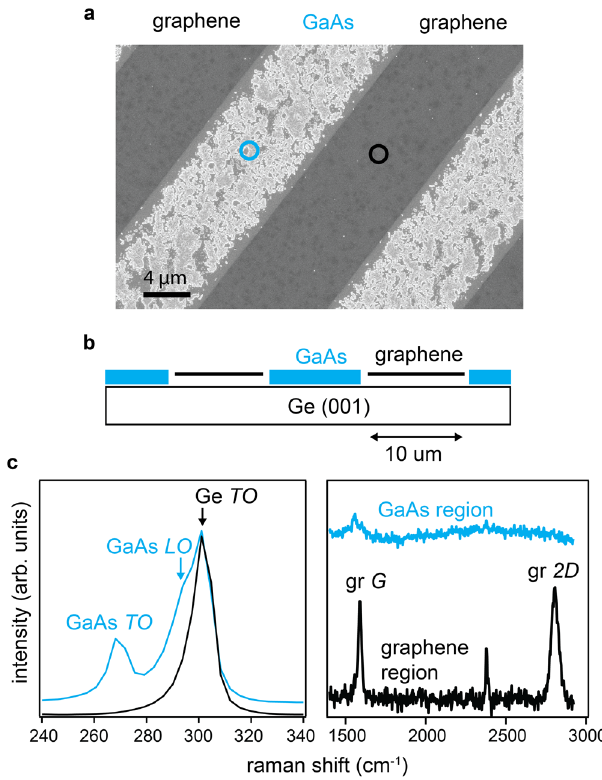
Fig. 7 GaAs selectivity on patterned graphene/Ge. The graphene was grown directly on the Ge (001) by CVD, thus avoiding the damage and interfacial oxides typically present for graphene layer transfers. We use photolithography and an oxygen plasma etch to de fi ne 10 micron wide stripes of alternating graphene and exposed Ge substrate. GaAs fi lms were then grown on the patterned graphene substrate by MBE. a SEM image of GaAs nucleation on patterned graphene on a Ge (001) substrate. We observe selective nucleation of GaAs (light color) on the exposed Ge regions of the substrate, and no GaAs nucleation on the graphene. b Cartoon of the sample. c Raman spectra on the graphene masked region (black curves) and on the GaAs nucleation region (blue). Representative areas for these spectra are marked by the circles in the SEM image ( a